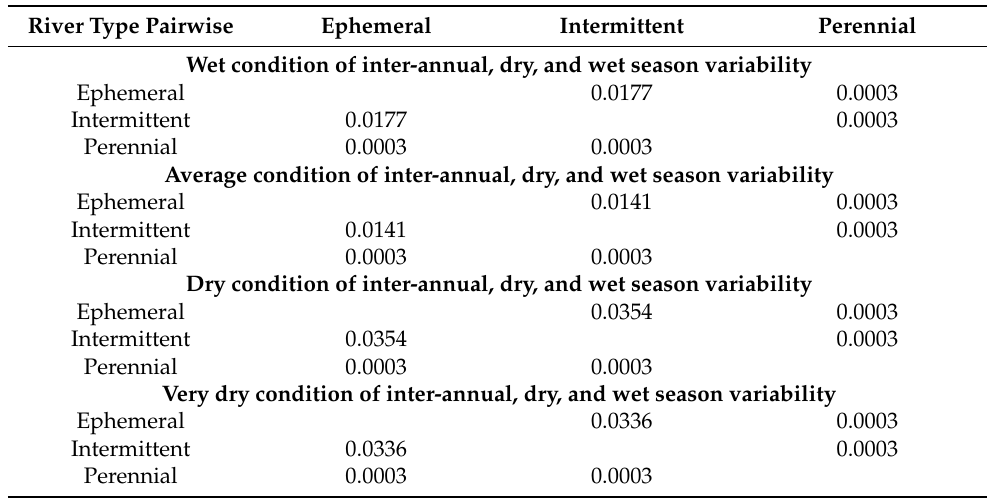
Table 4. Pairwise test of response variables between the groups per river type (one-way PER- MANOVA). P -values with Bonferroni correction (Euclidean similarity index, permutation 9999